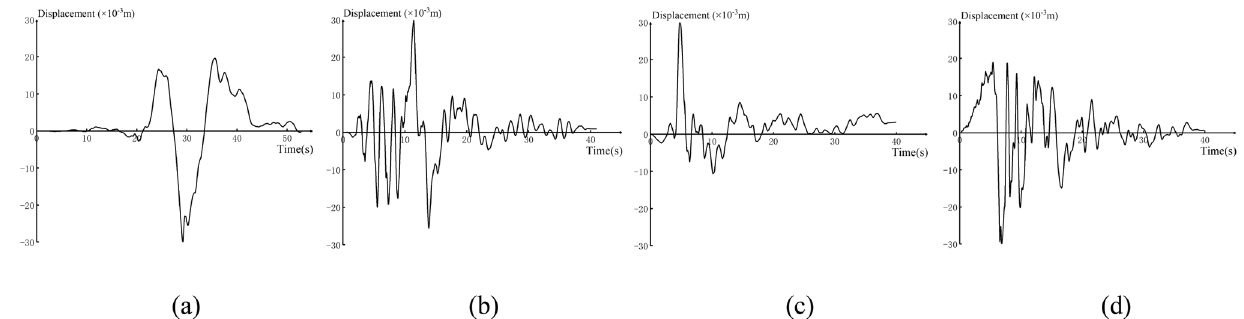
Fig. 18 Displacement motion input (scaled): a Chi-Chi earthquake; b Kobe earthquake; c Loma Prieta earthquake; d Northridge earthquake